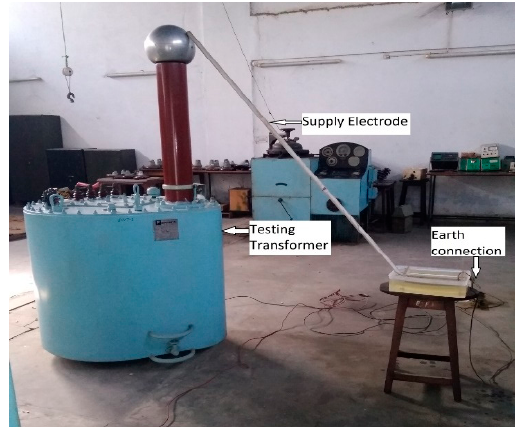
Figure 5. High-voltage testing transformer and experimental set up.